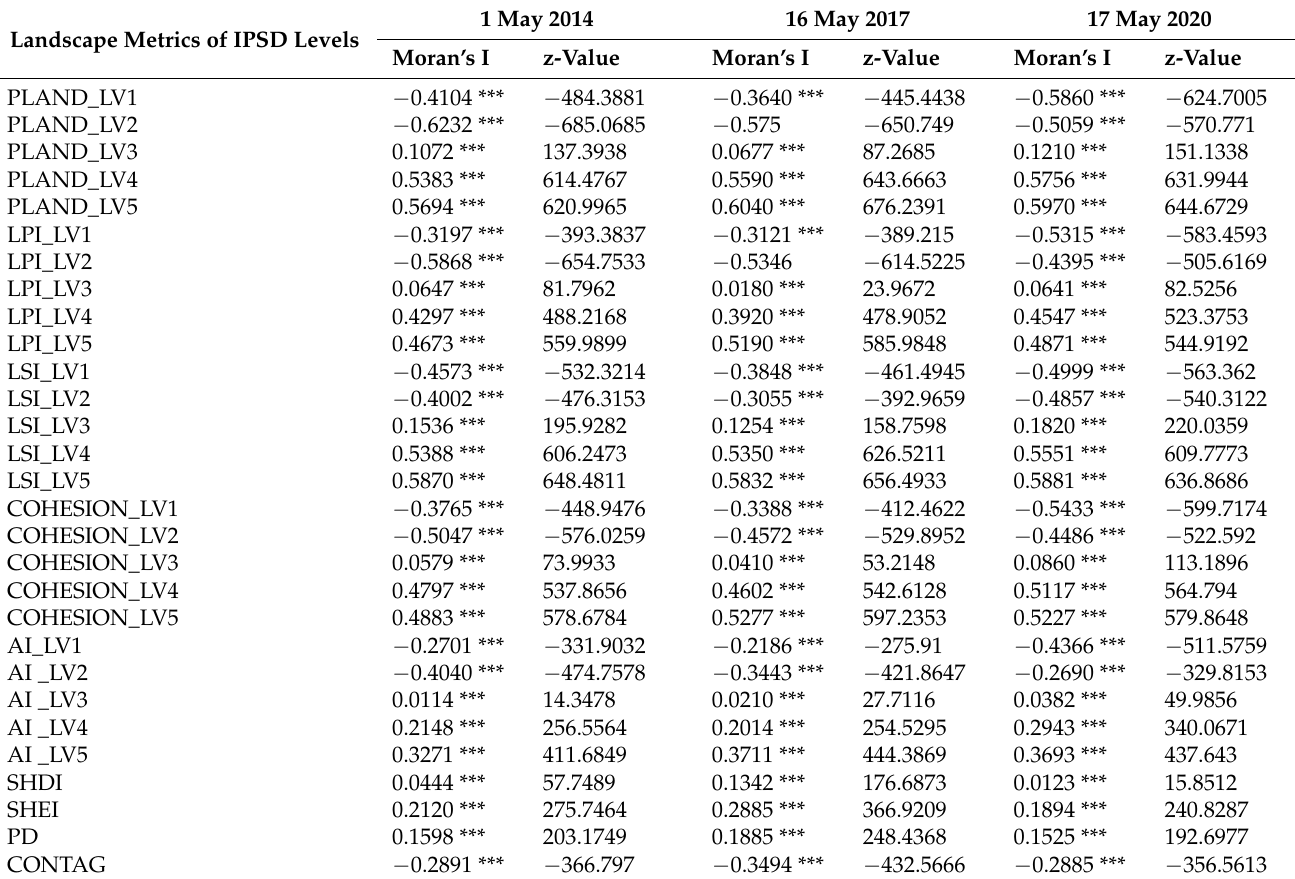
Table 5. Bivariate Global Moran’s I between landscape metrics of IPSD levels and LST. Landscape Metrics of IPSD